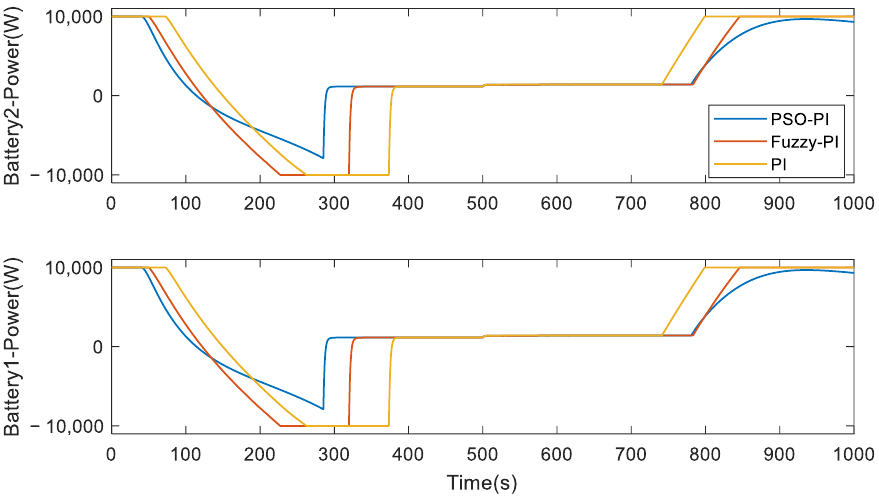
Figure 31. Output power of battery in Example 3.